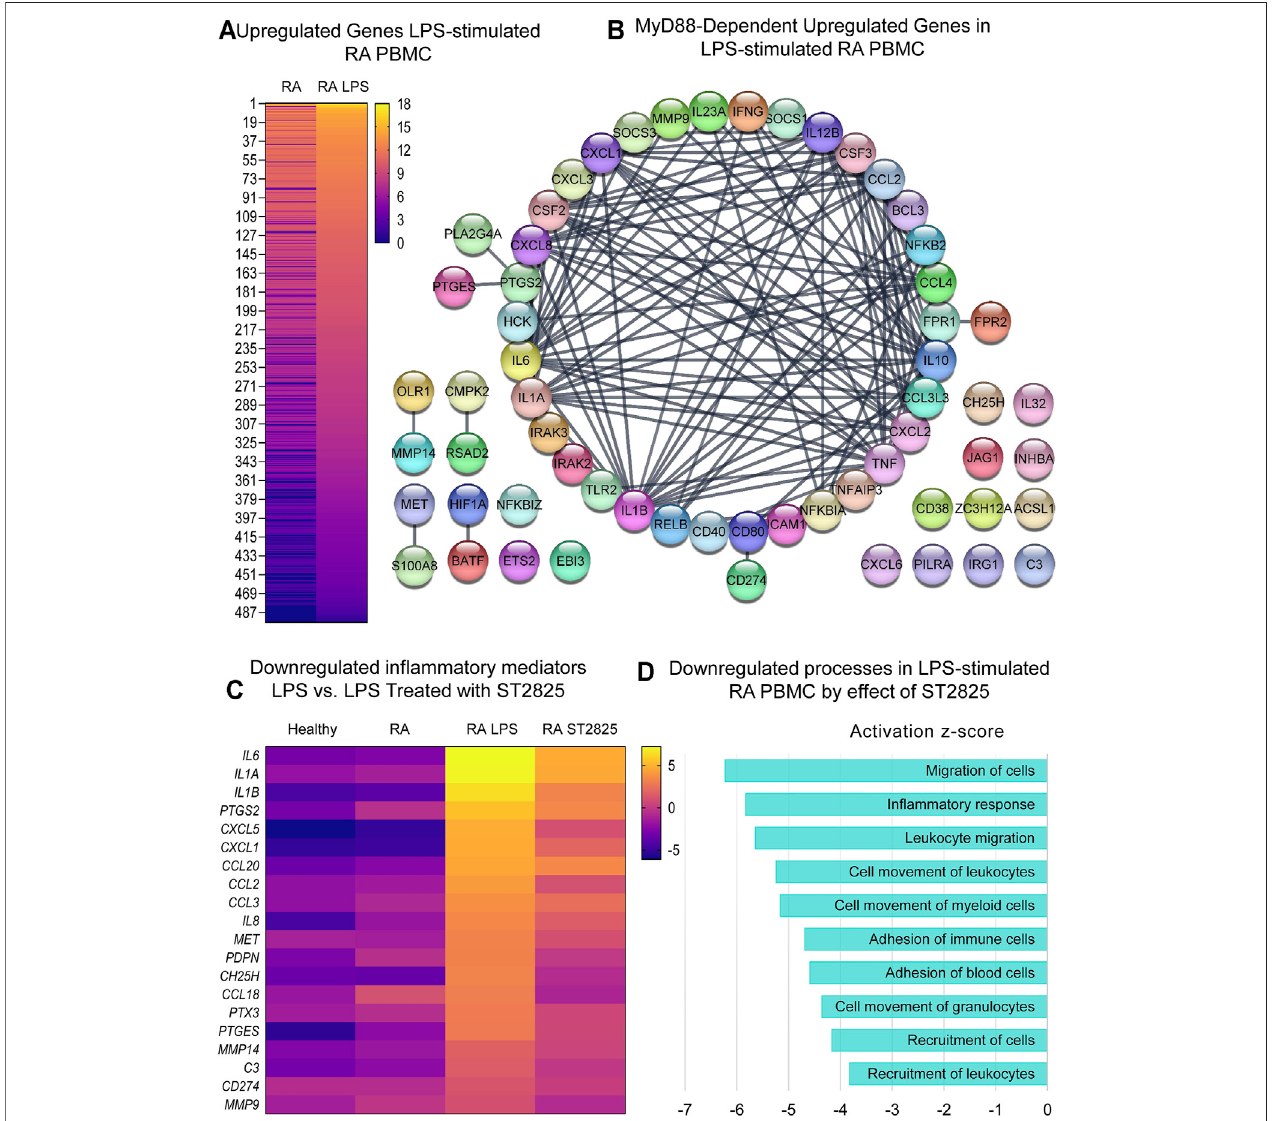
FIGURE3| MyD88inhibitionbyST2825downregulateskeyin fl ammatorymediatorsandpathogenicprocessesinLPS-stimulatedPBMCfromDMARDs-naïveRA patients. (A) Transcriptomic signatures from RA PBMC and RA LPS-stimulated PBMC are presented in the heatmap (averaged expression patterns of